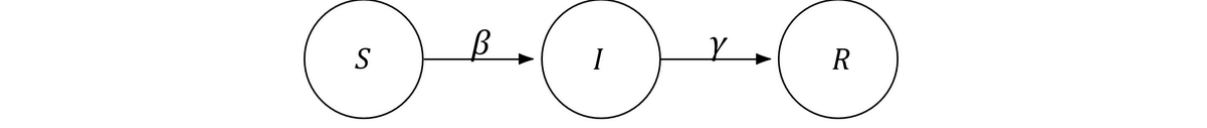
Figure 2. Susceptible-infected-removed model diagram showing compartments and flow. I: infected; R: removed; S: